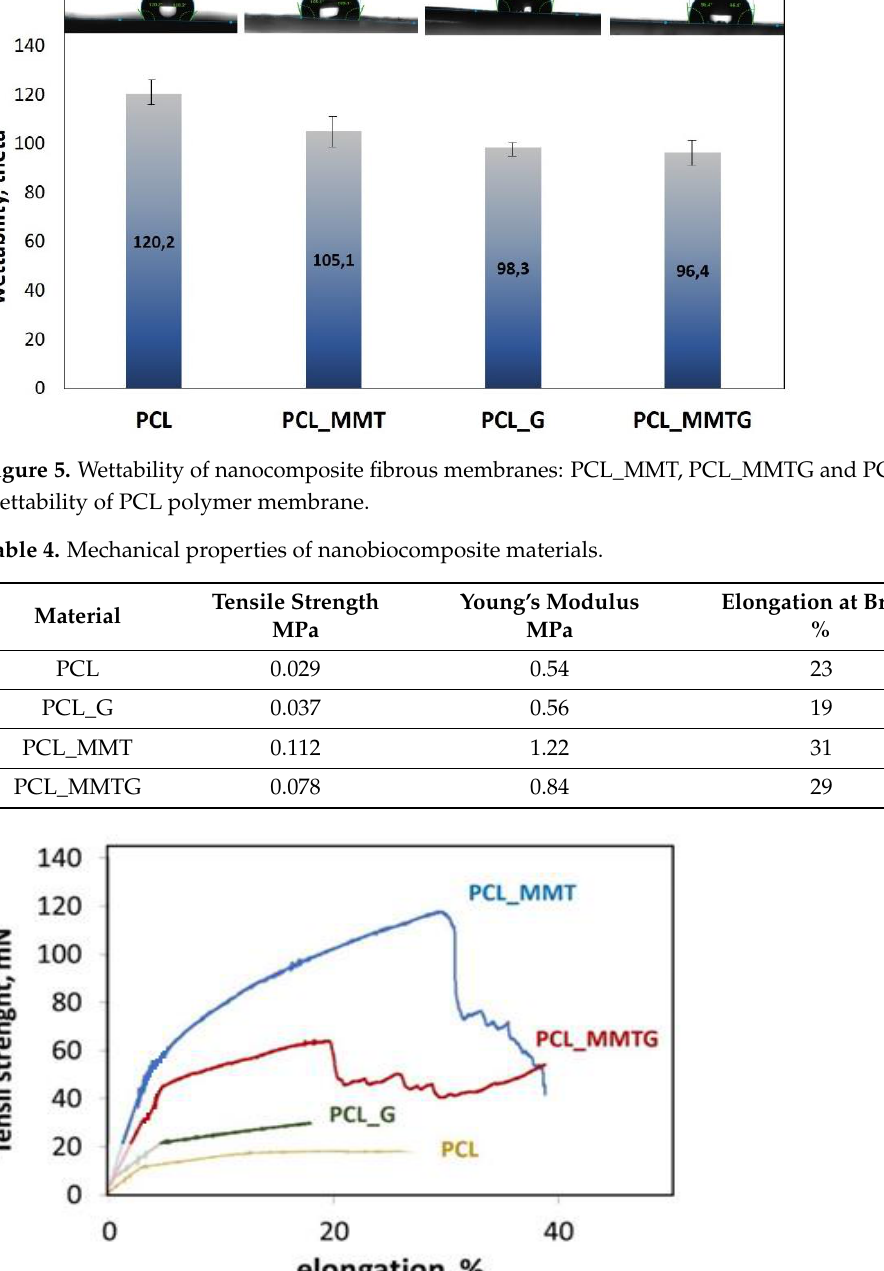
Table 4. Mechanical properties of nanobiocomposite materials.